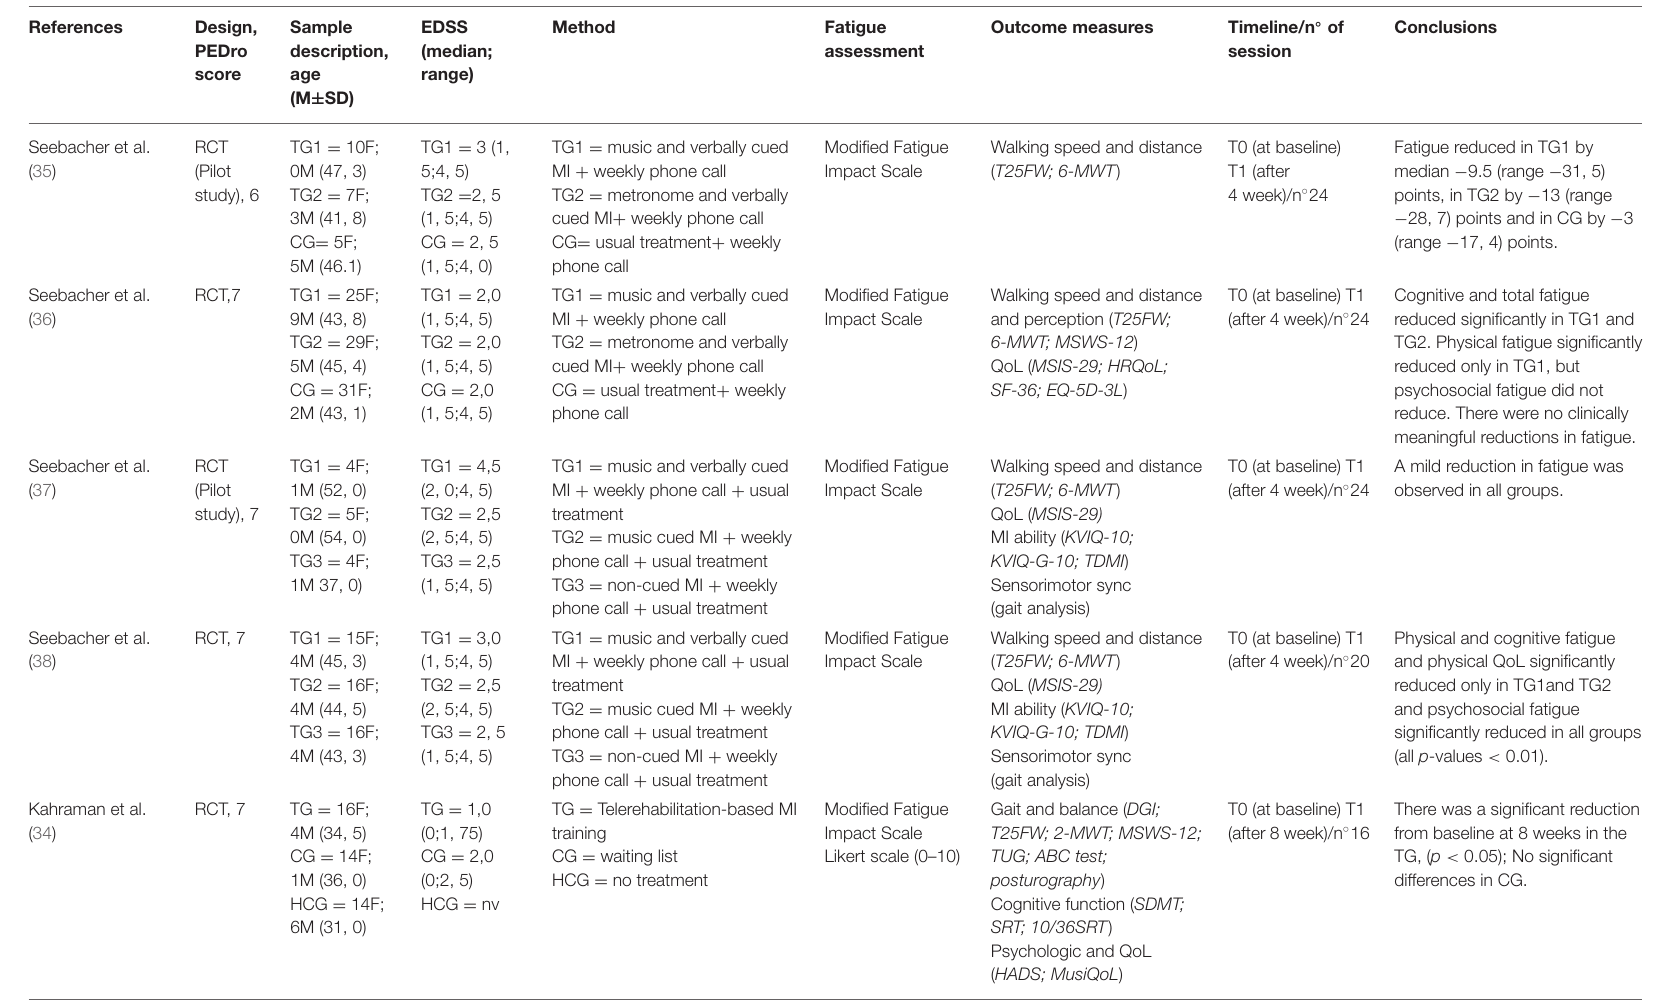
TABLE 2 | Summary of the intervention and outcomes (or results) of the included